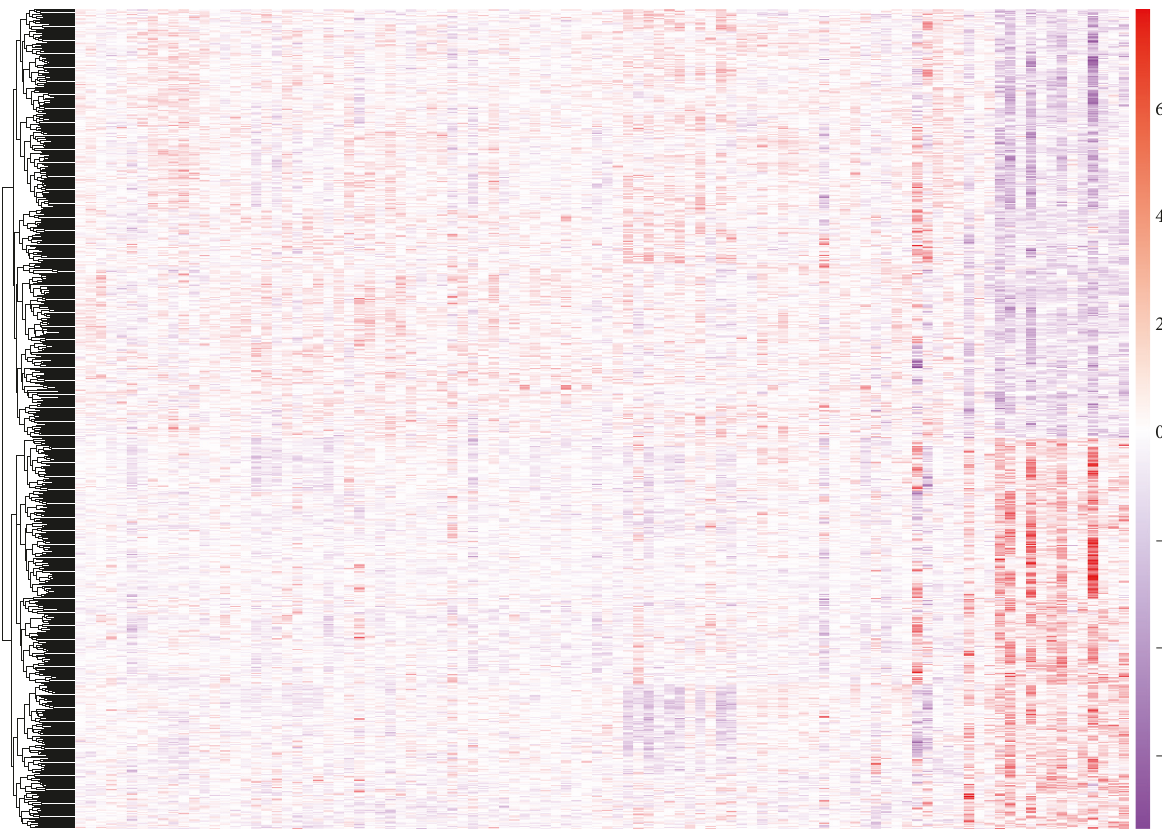
Figure 1: Heat map of all DEGs in HF. Orange represents upregulated DEGs, and purple represents downregulated